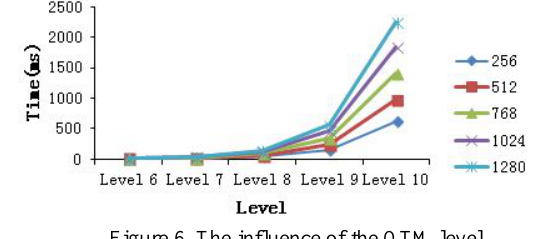
Figure 6. The influence of the QTM level Figure 5 shows that the time for generating the spherical Voronoi diagrams is linear to the amount of the input sites. This is only for the point sets. As for line sets, the time is linear to the number of the grids the line go through; and for area sets, the time is linear to the number of the grids that form the edges of the area. Figure 6 shows that the generating time increases exponentially as the growth of the level, this is because the number of the grids on the sphere is exponential to the QTM level. Although time consuming, the Voronoi diagram we get from higher level of QTM grids is of greater quality. Figure 7 shows the Voronoi diagrams generated by the centers of all the countries in the world in different QTM Levels. So, under the condition that the precision is satisfied, we should use lower level to get a higher efficiency.